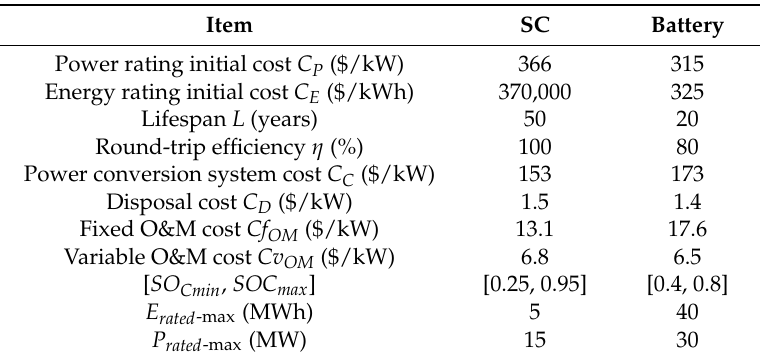
Table 2. Parameters of supercapacitor (SC) and battery.